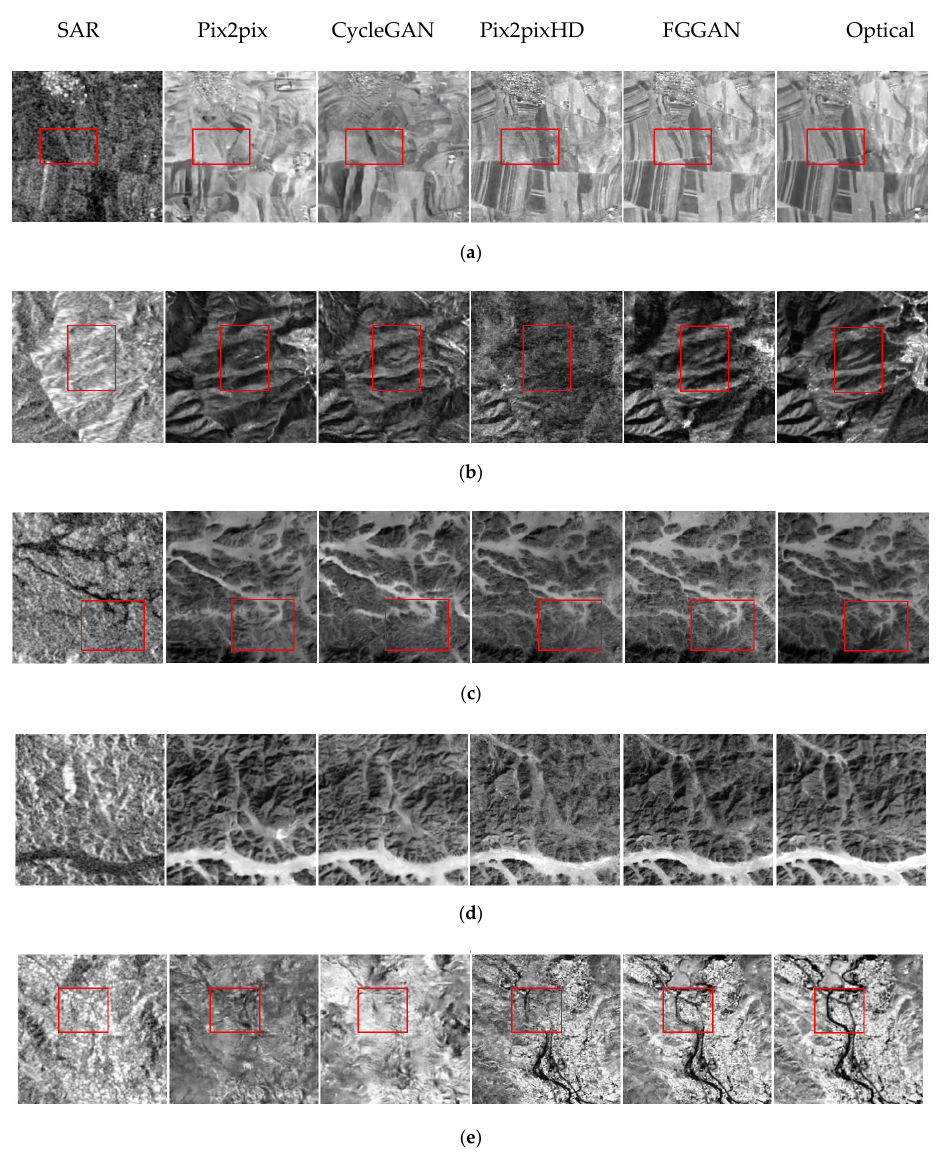
Figure 5. Multiple scenes image translation results obtained by pixel to pixel (pix2pix), cycle-consistent adversarial networks (CycleGAN), high-definition pixel to pixel (pix2pixHD) and feature-guided SAR-to-optical image translation (FGGAN). ( a ) Farmland, ( b ) Forest, ( c ) Gorge, ( d ) River, and ( e ) Residential.